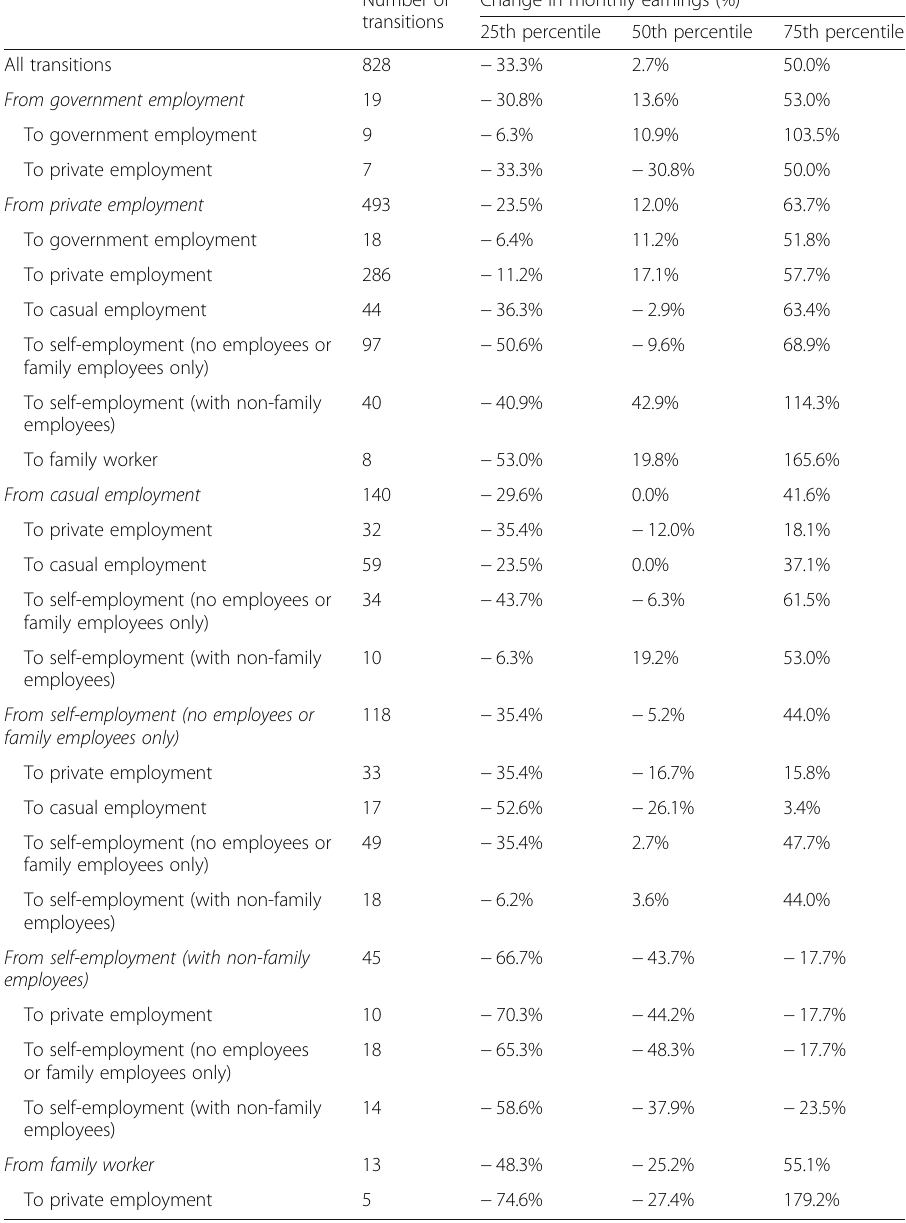
Table 14 Percentage change in earnings by employment type transition